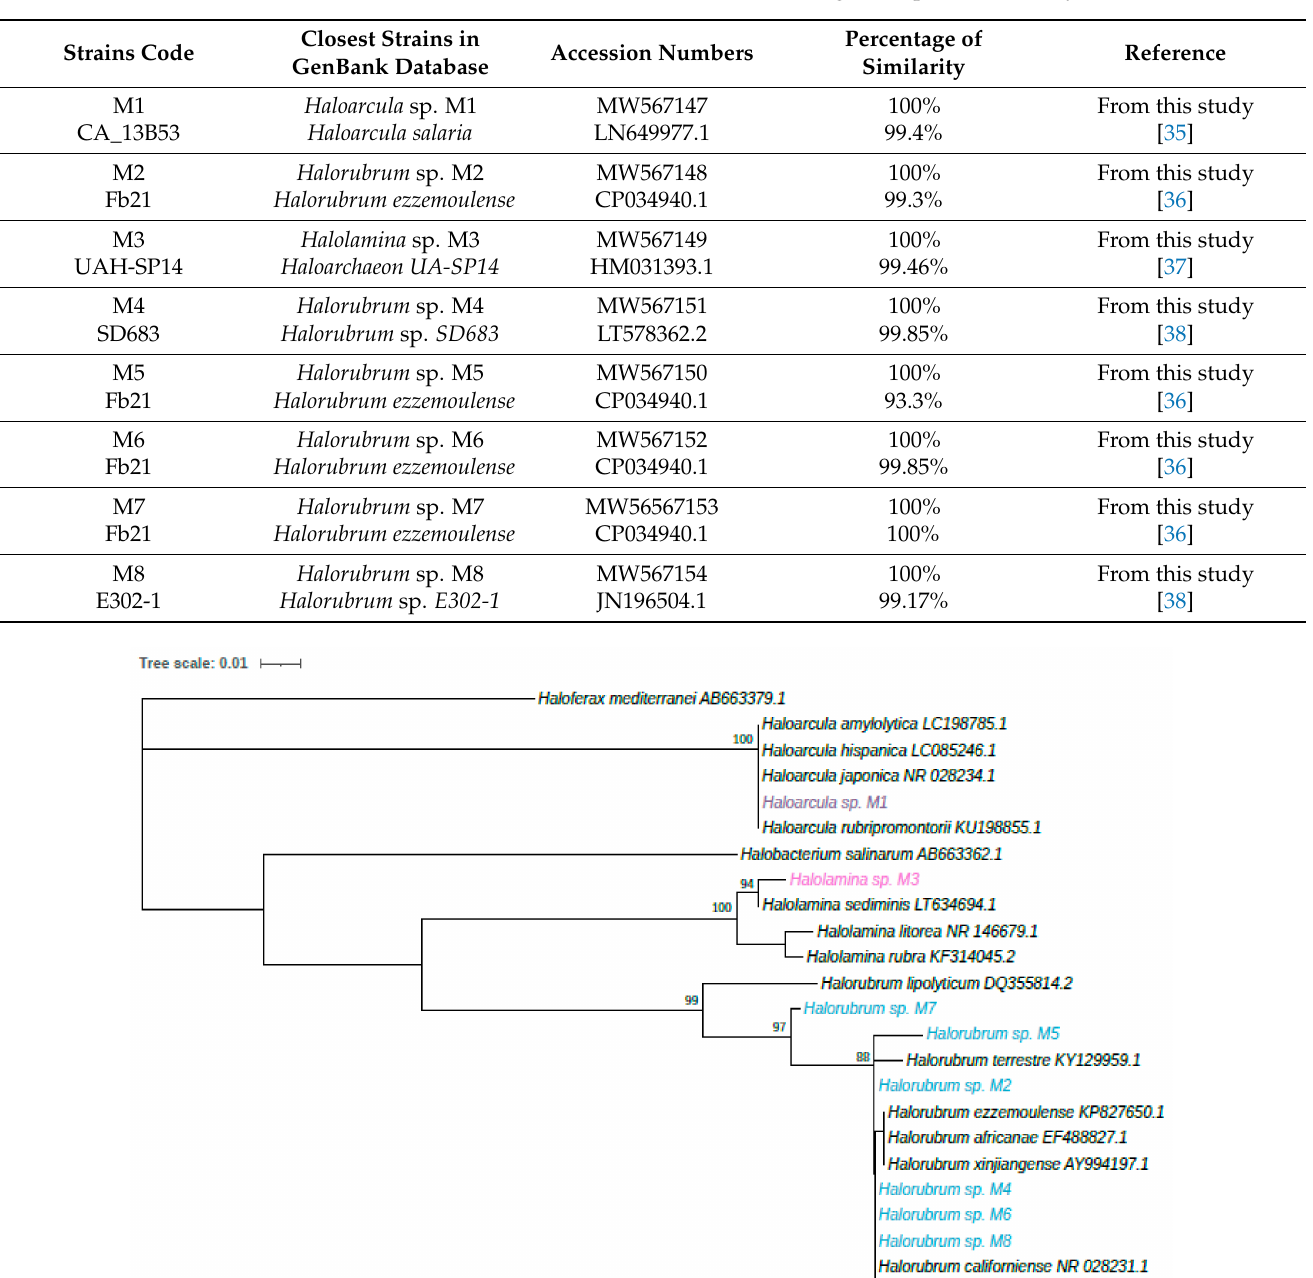
Table 1. Closest related strains of isolates based on 16S rRNA gene sequence similarity.